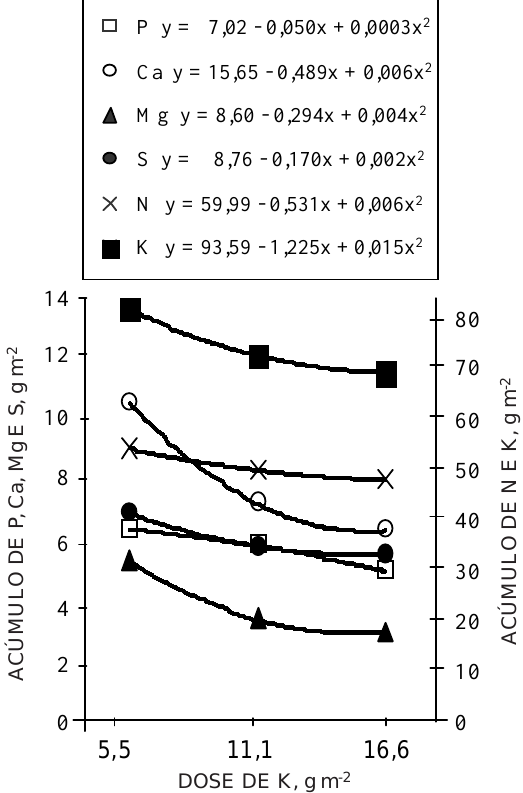
Figura 2. Acúmulo de nutrientes pela parte aérea do pimentão (caule, folhas e frutos), considerando a aplicação de K no solo, na dose de N de 26,6 g m -2 , após 34 semanas de cultivo em ambiente protegido.